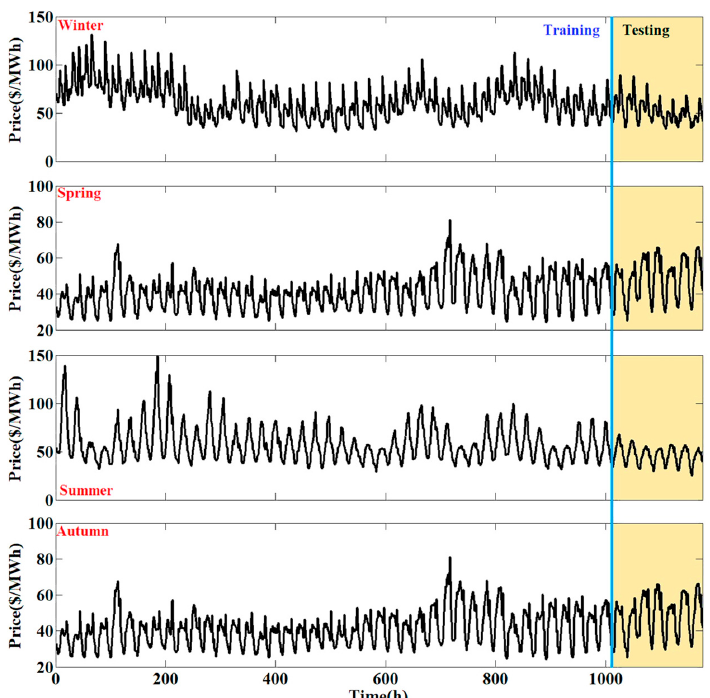
Table 2. The studied period in 2018 for the electricity market of the US.